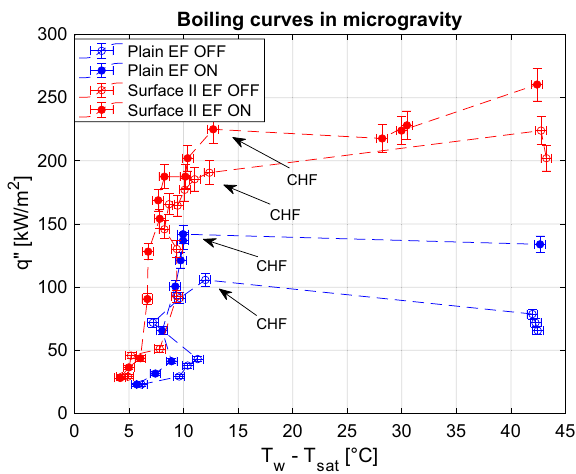
Fig. 9 Boiling curves of the plain surface and surface II (example of microstructured surfaces) obtained in microgravity conditions. Error bars represent the measurement uncertainty (see “ Methods ” section). The abrupt increase of the wall temperature indicates that CHF has been